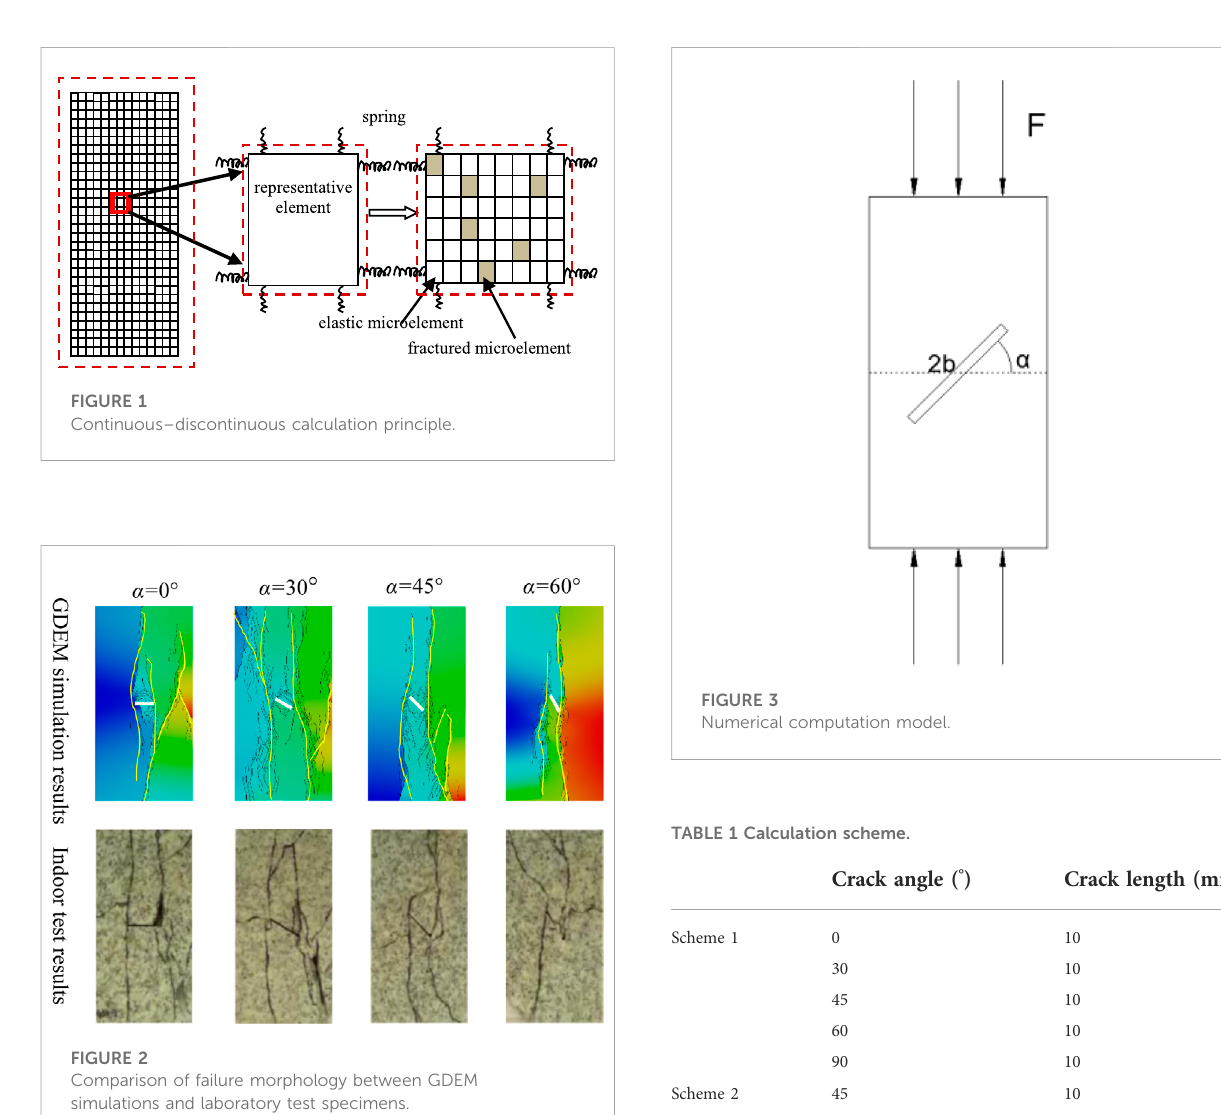
FIGURE 2 Comparison of failure morphology between GDEM simulations and laboratory test specimens.